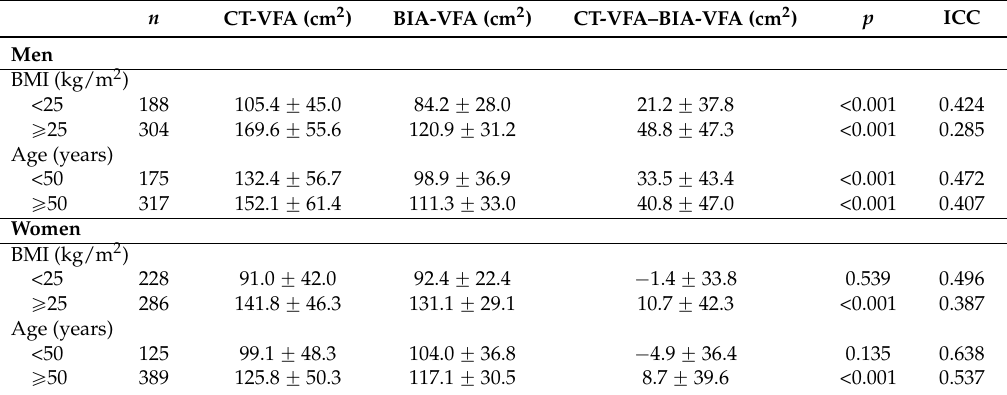
Table 4. Subgroup analyses of mean differences between CT-VFA and BIA-VFA by